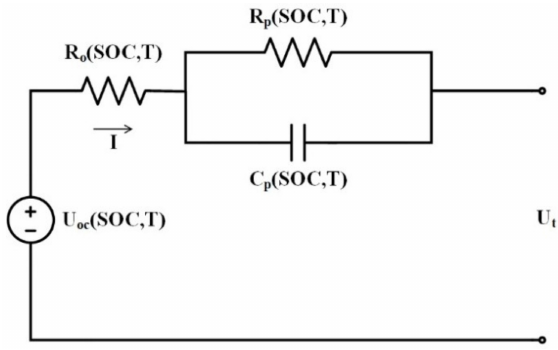
Figure 10. Migrated 1-RC model [28].